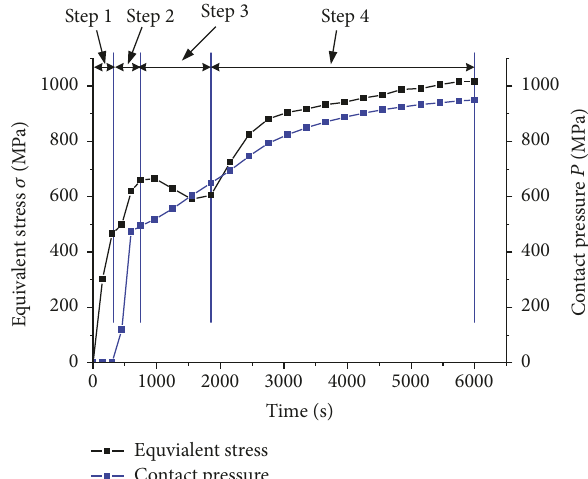
Figure 15: The variation of the maximum equivalent stress and contact pressure of the rear shaft hole during the start-up period.